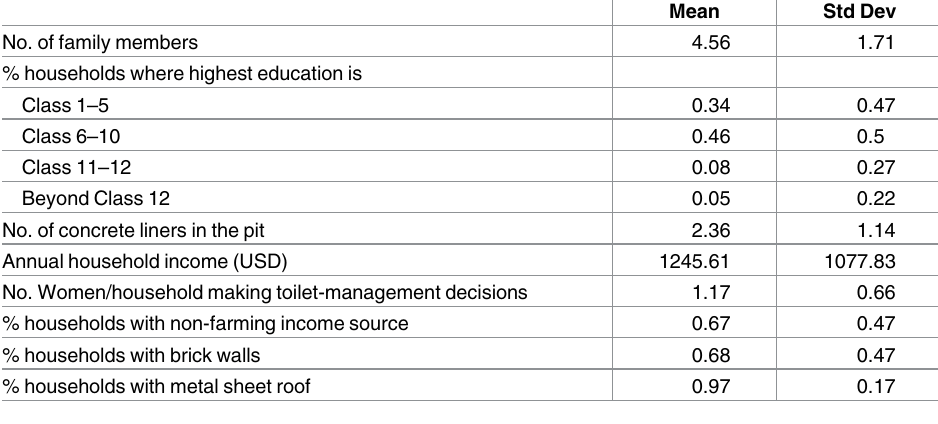
Table 9. Summary statistics for the